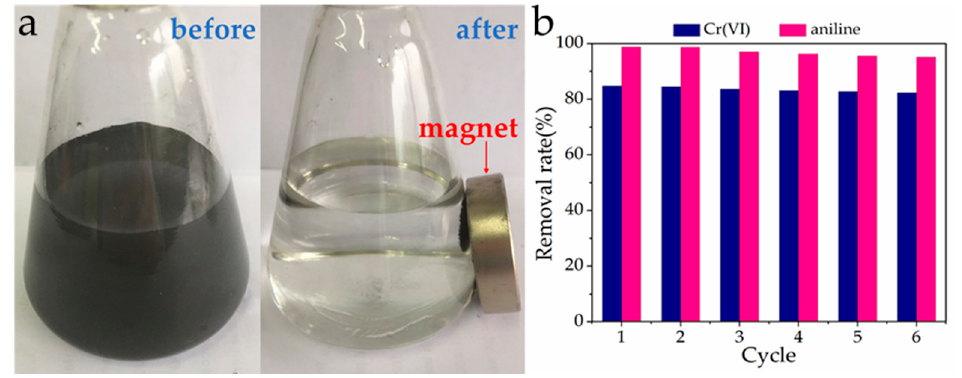
Figure 11. ( a ) Recycle of MFH from solution; ( b ) Reusability of MFH. ( c 0 (Cr(VI)) = 40.0 mg·L − 1 , c 0 (aniline) = 100.0 mg·L − 1 , c (MFH) = 0.10 g·L − 1 , pH = 3.0, T = 25 °C).